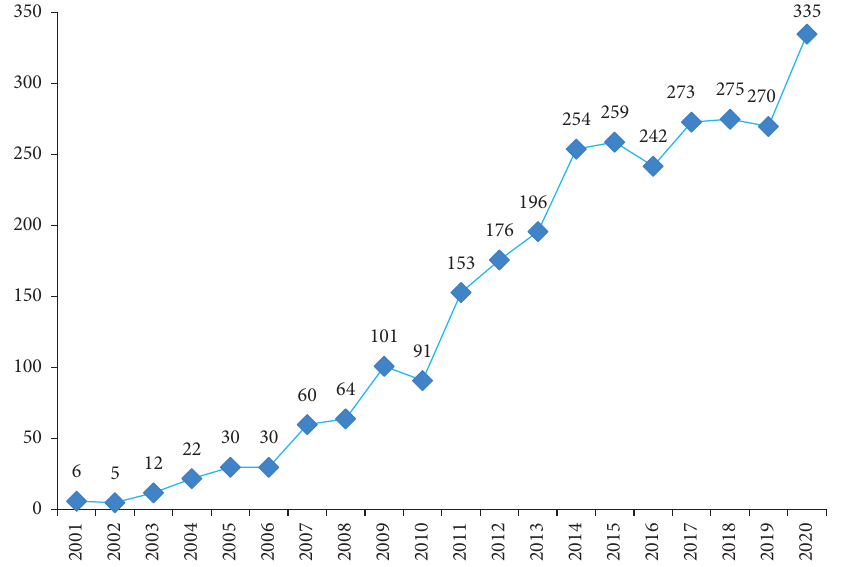
Figure 1: Time series distribution of